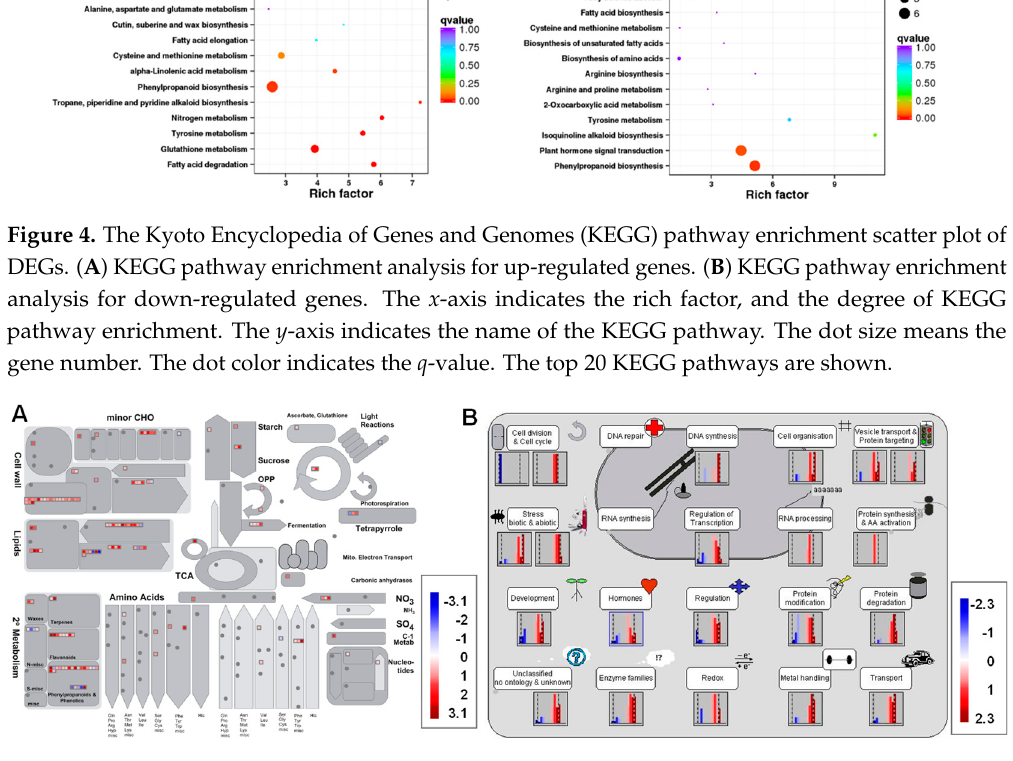
Figure 5. MapMan overview of the DEGs in the quercetin-treated rice roots. ( A ) The metabolism overview in MapMan. ( B ) The cell functions overview in MapMan. The DEGs were binned to the MapMan functional categories. The values are the log 2 fold changes. The up-regulated and down-regulated genes are represented with red and blue squares, respectively. Details about the genes are shown in Table S8 .